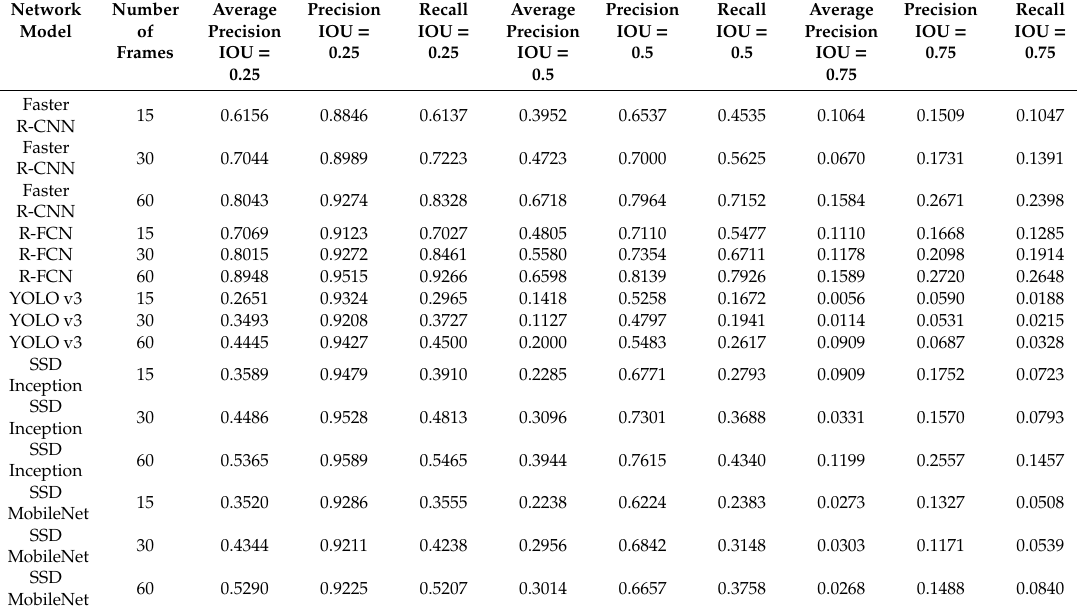
Table 2. Summary of the analyses results for all the applied convolutional neural networks. IOU—intersection over union.